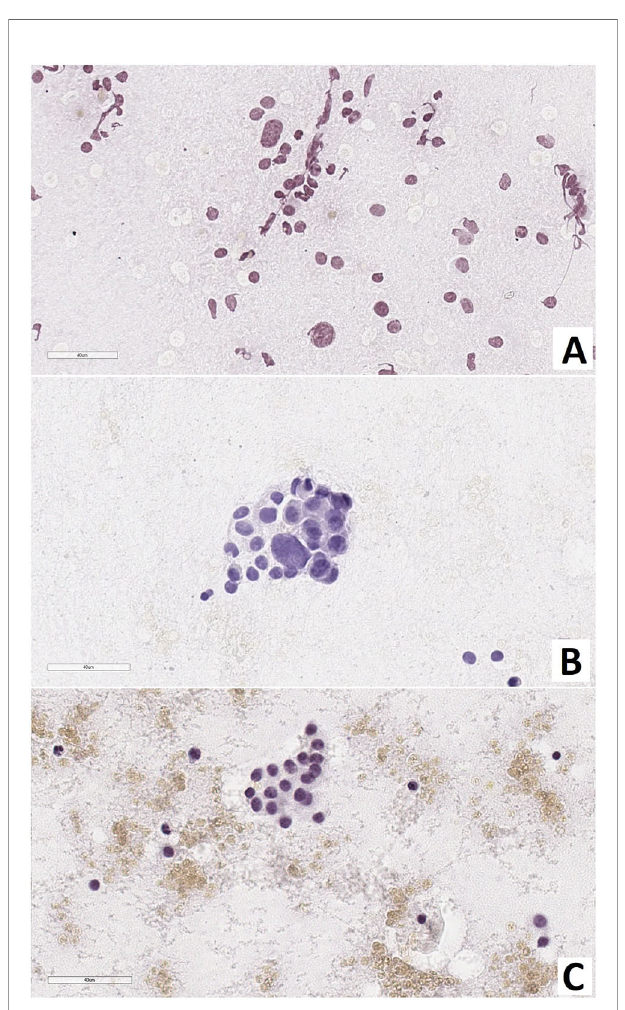
FIGURE 2 | Pancreas smear prints. Large nuclei are 2-3 times larger than neighboringnuclei. (A) – focal form of congenitalhyperinsulinism, (B) – diffuse formof congenital hyperinsulinism, (C) – control.Hematoxylin and eosin staining.